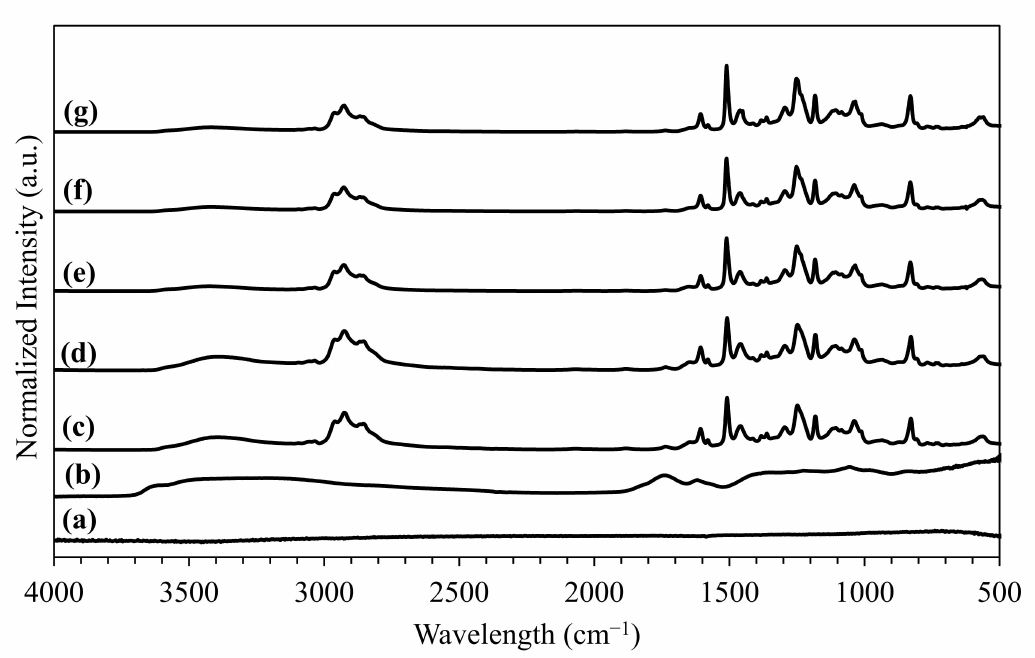
Figure 2. Fourier transform infrared (FTIR) spectra of ( a ) graphite; ( b ) GO; ( c ) pure bio-epoxy; ( d ) bio-epoxy/0.2 wt.% GO; ( e ) bio-epoxy/0.3 wt.% GO; ( f ) bio-epoxy/0.6 wt.% GO and ( g ) bio-epoxy/1.2 wt.%